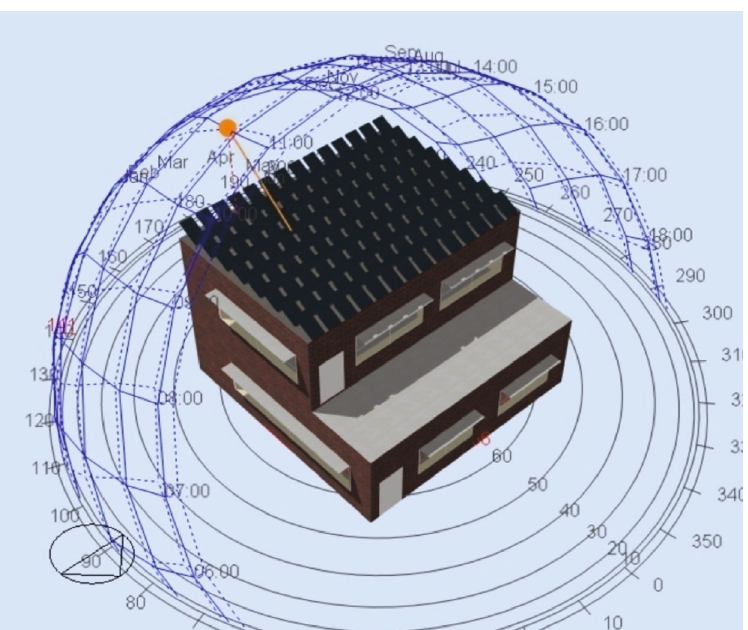
Figure 10: The schematic plan of sun radiation path in the 15th of